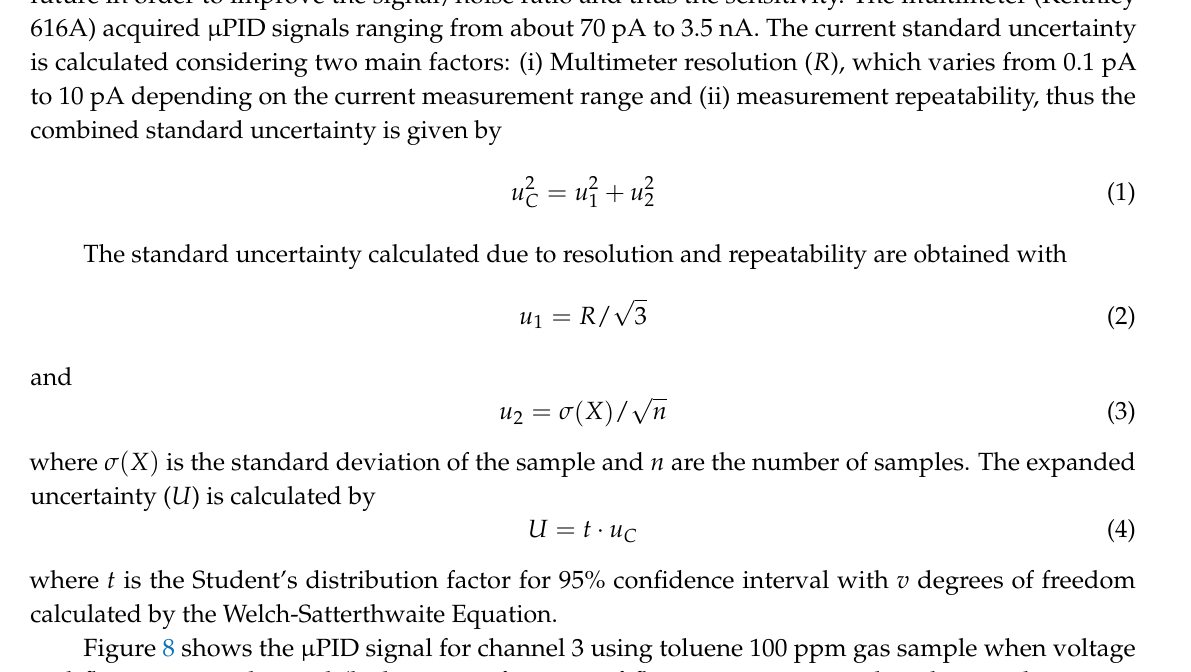
Figure 7. Digital optical microscope images of copper electrodes assembled on bottom polymethyl methacrylate (PMMA). ( a ) Channel 1; ( b ) Zoom at bottom PMMA and copper electrodes assembly; ( c ) Channel 2.